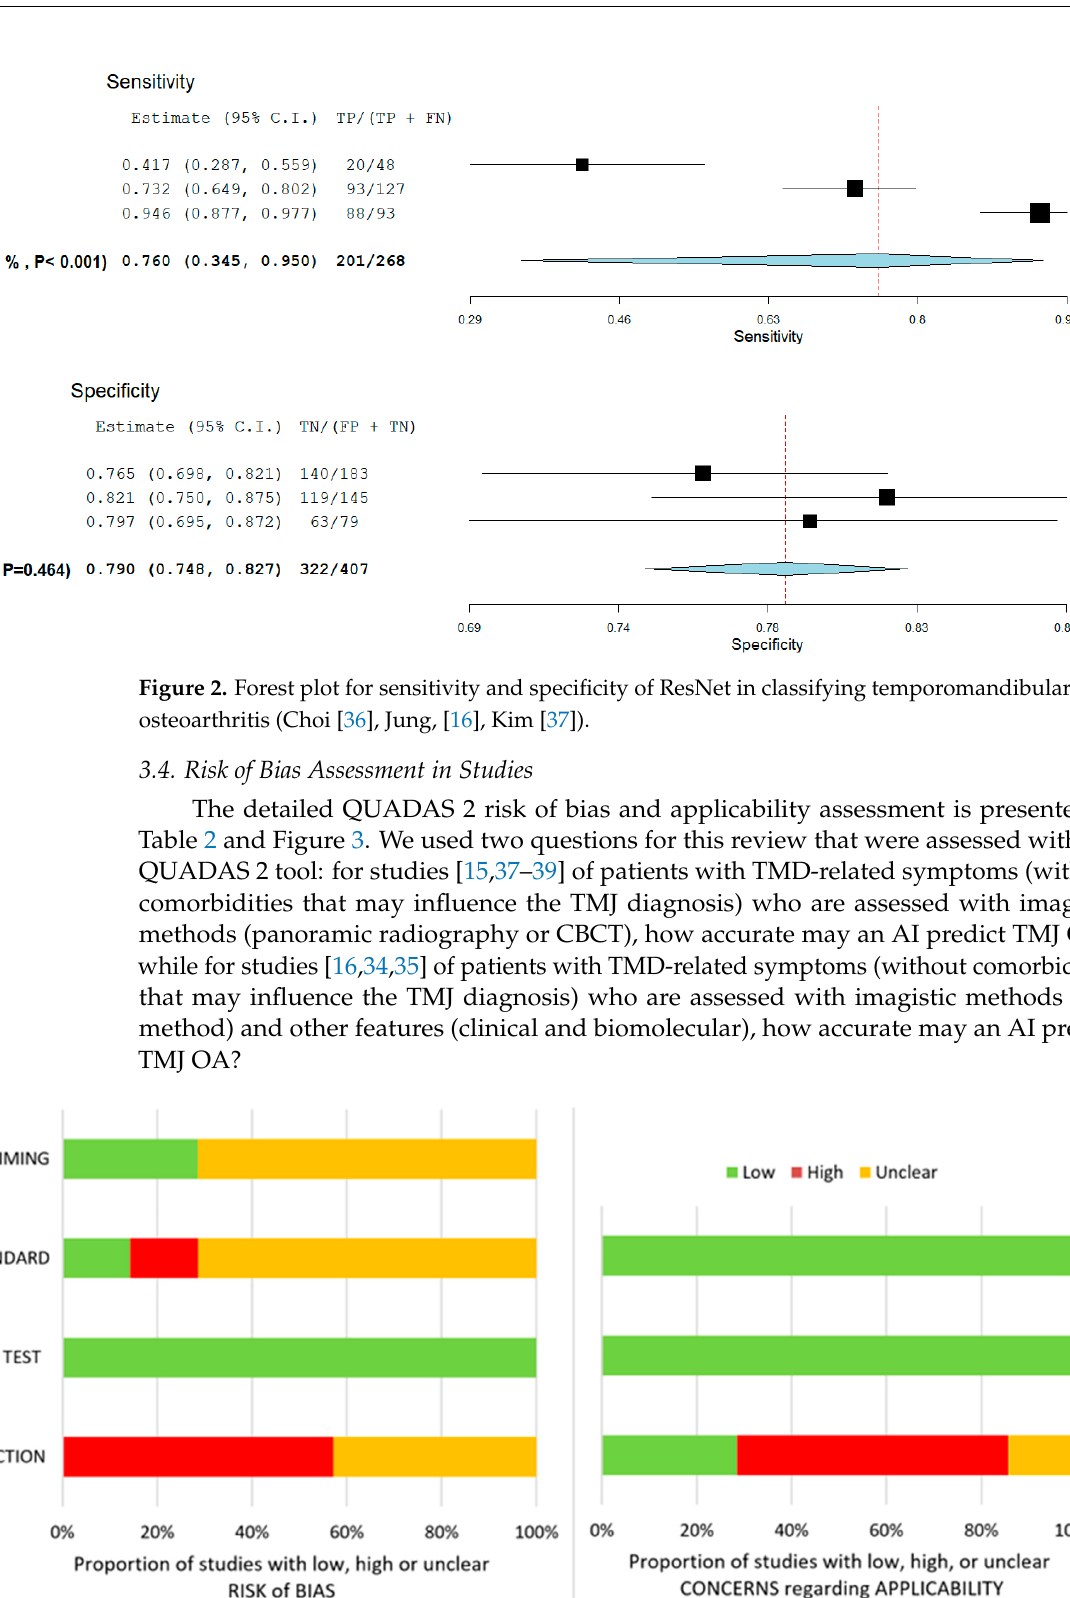
Figure 3. QUADAS 2 risk of bias and overall applicability assessment.